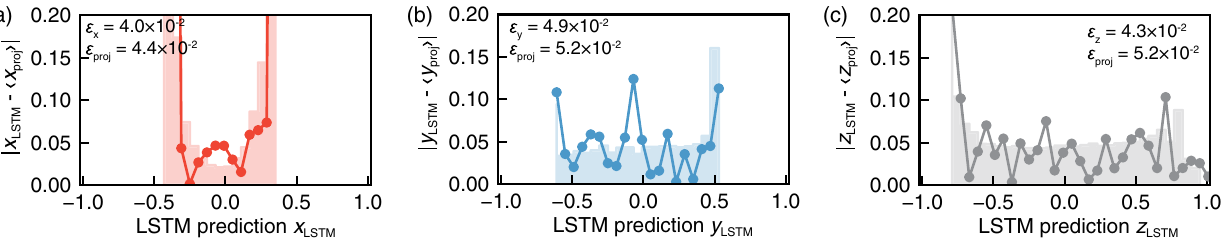
FIG. 9. Comparison of the LSTM prediction error (dots) and expected uncertainty in the estimate of the ground truth h x proj ;i i [histograms calculated from Eq. (F2)] for Bloch coordinates x (a), y (b), and z (c). ε are the weighted rms errors calculated from x;y;z − h x σ LSTM predictions, and ε is calculated from Eq. (F1) while setting x . ε thus represents the weighted rms proj LSTM ;i proj ;i i ¼ proj h x proj ;i i due to a limited number of trajectories. Since both error in case of perfect LSTM predictions and 1 σ statistical fluctuation in h x proj ;i i and ε are consistent, we conclude that our accuracy measure is limited by quantities follow similar trends and their magnitudes ε x;y;z proj the number of